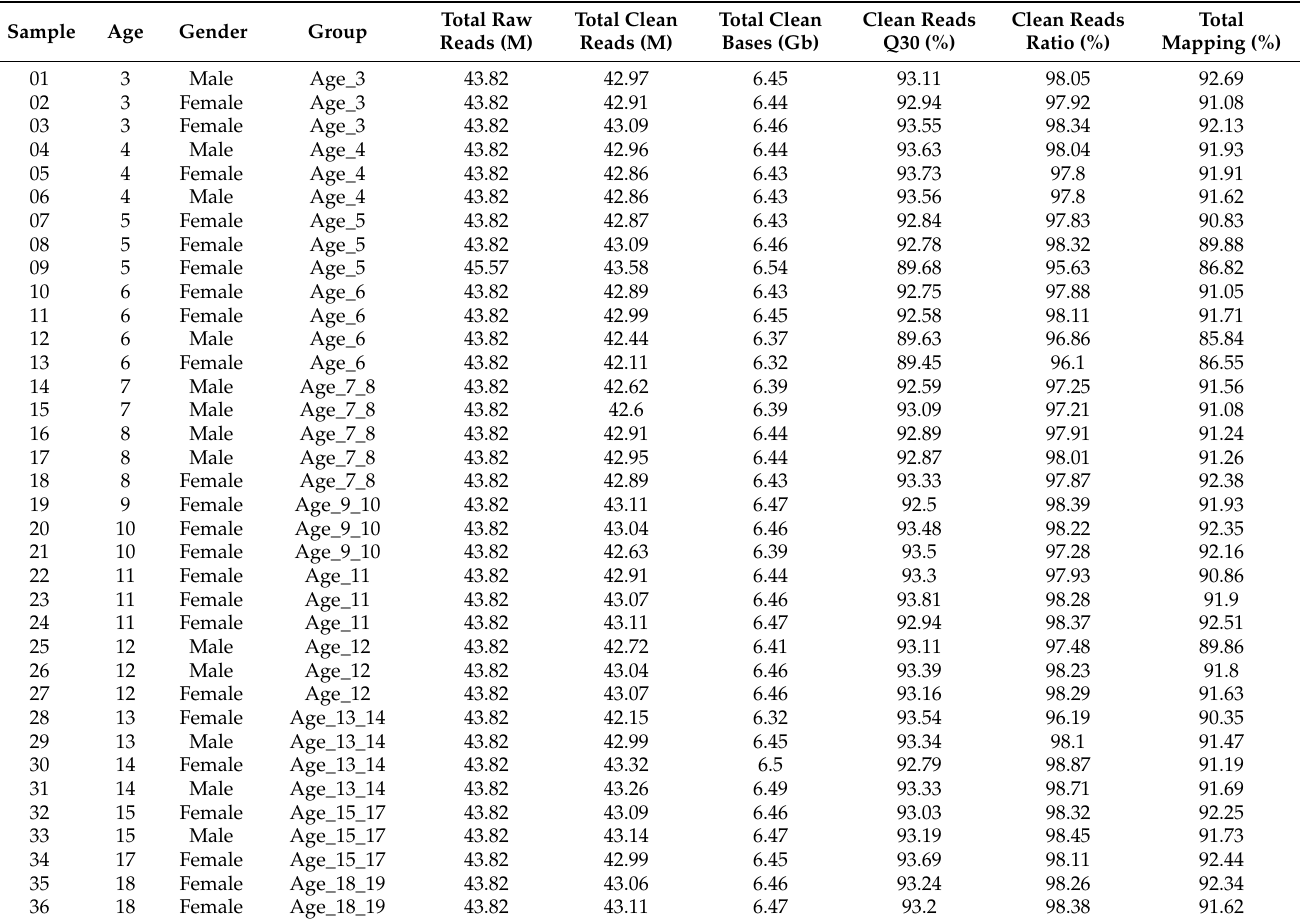
Table 1. Summary of sequencing and assembly of the